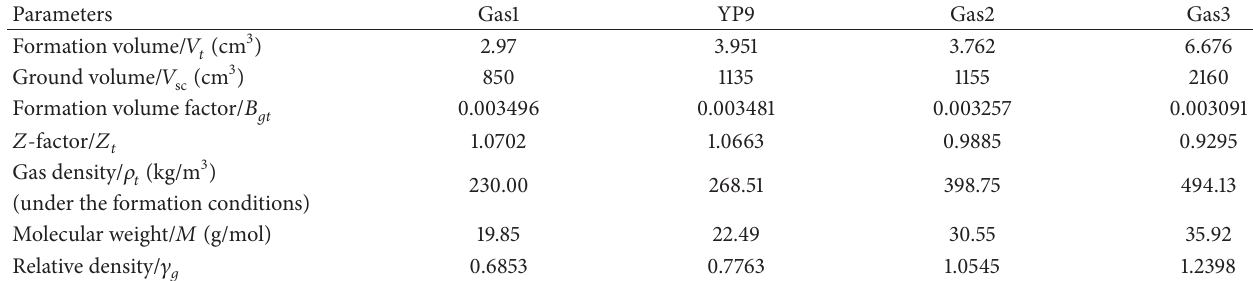
contents in natural 2